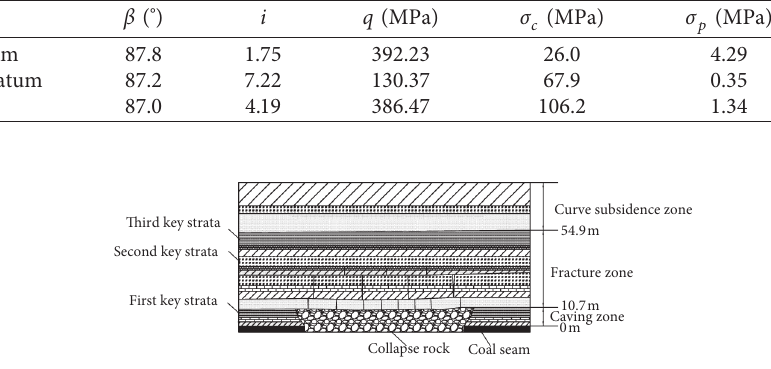
Figure 3: Distribution of fracture zone.